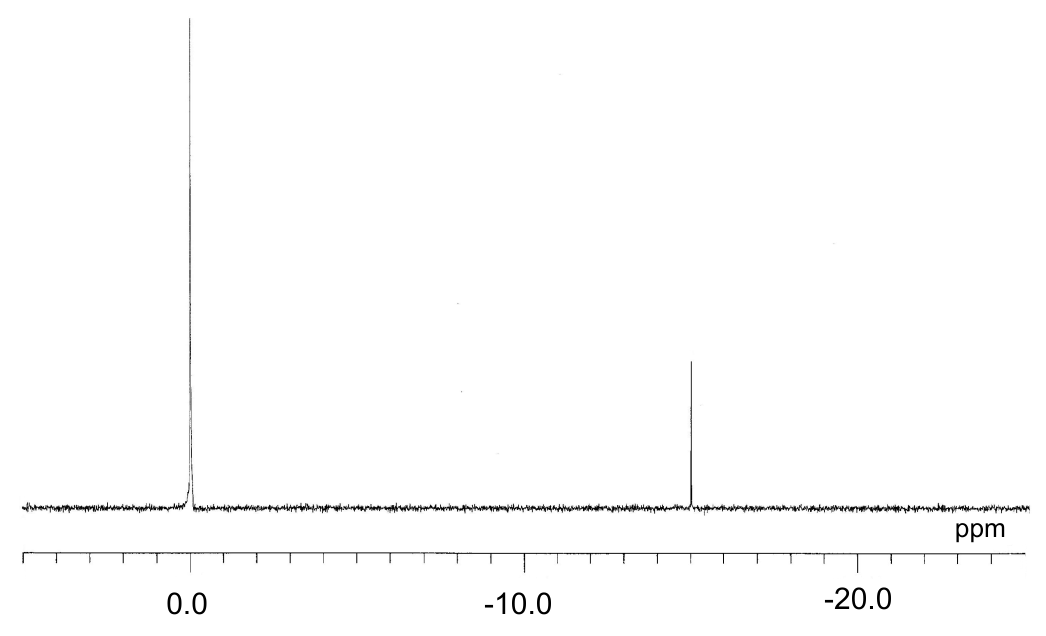
of Me NH -2 . The resonance at 0.0 ppm is due to 6 2 2 PO 3 4